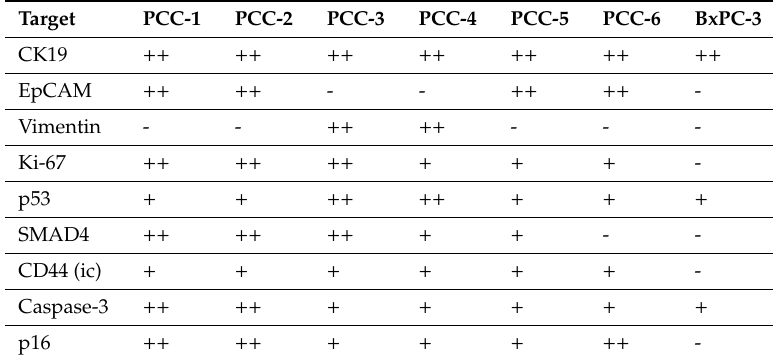
Table 2. Immunocytochemical analysis of markers for PDAC-derived primary PCC